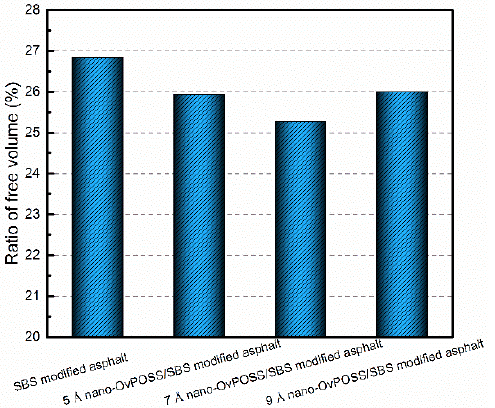
Figure 16. RFV of modified asphalt systems.